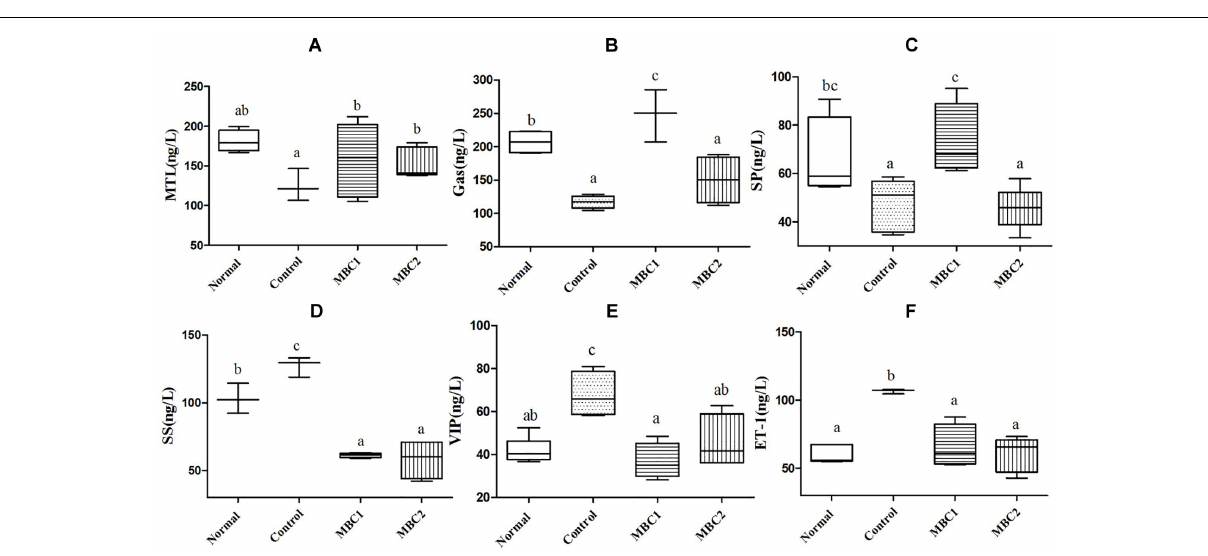
FIGURE 2 | Effects of CMB on constipation-related GI neurotransmitters. A, MTL; B, Gas; C, SP; D, SS; E, VIP; F, ET-1; a–c, mean values with different letters over the bars are significantly different ( p < 0.05) according to Duncan’s multiple range test.